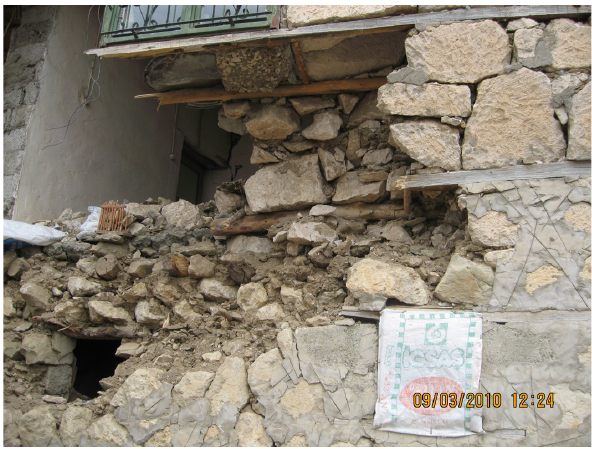
Fig. 6. No interlocking between wall leaves.